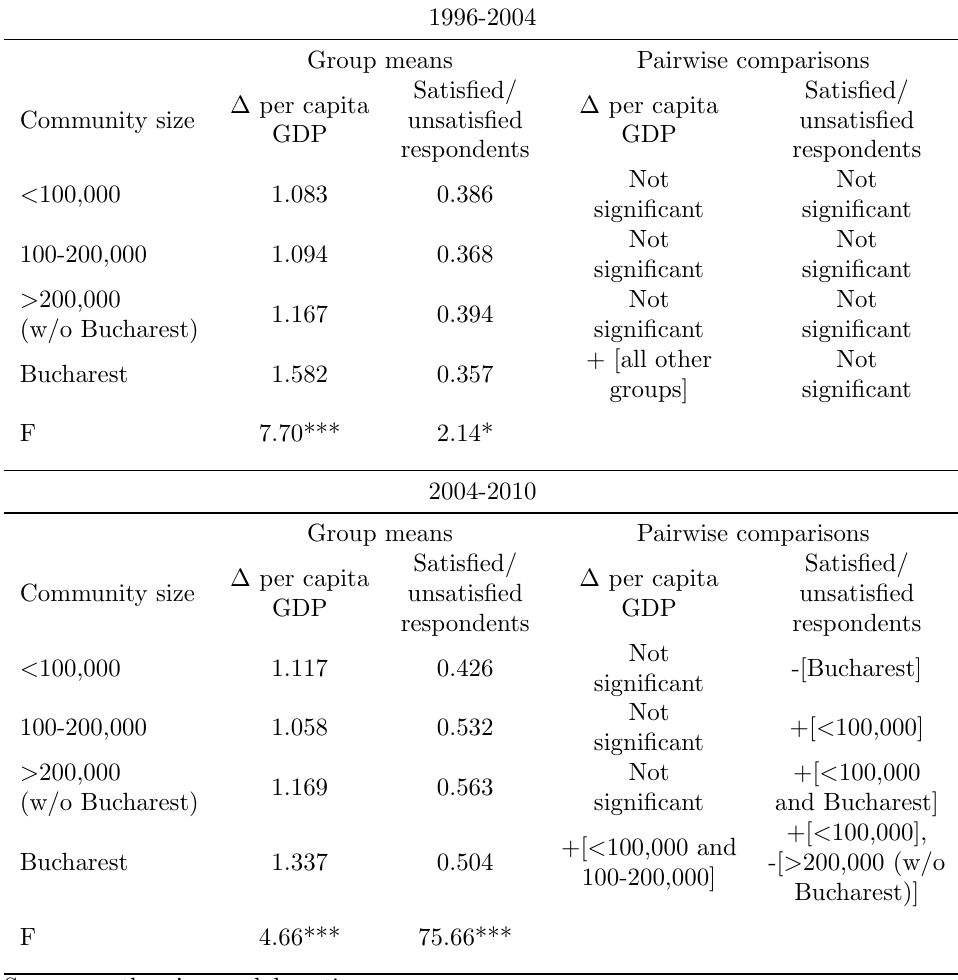
Table 4: Per capita GDP growth rate and life satisfaction by different typologies of NUTS3 regions: ANOVA